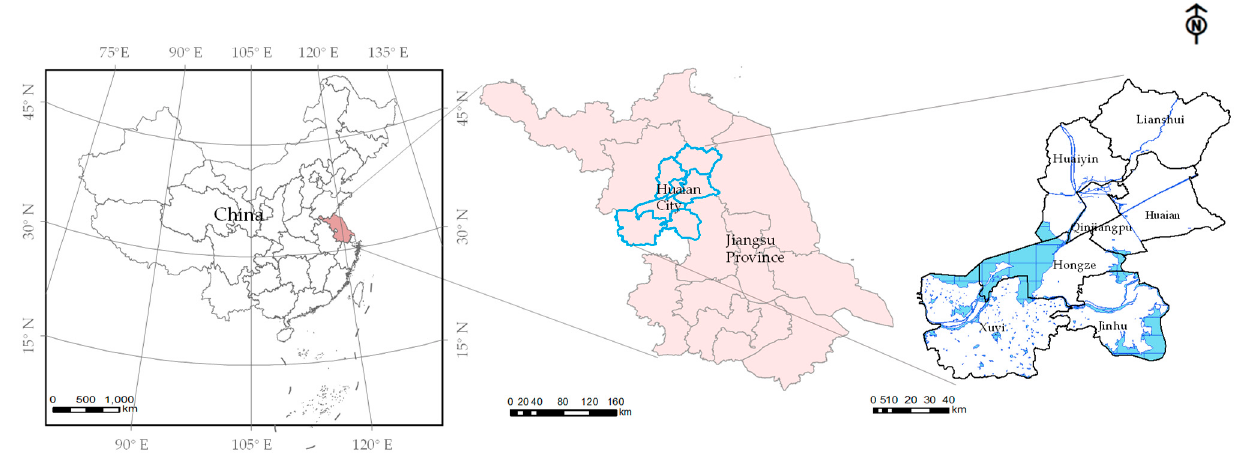
Figure 1. Study area.